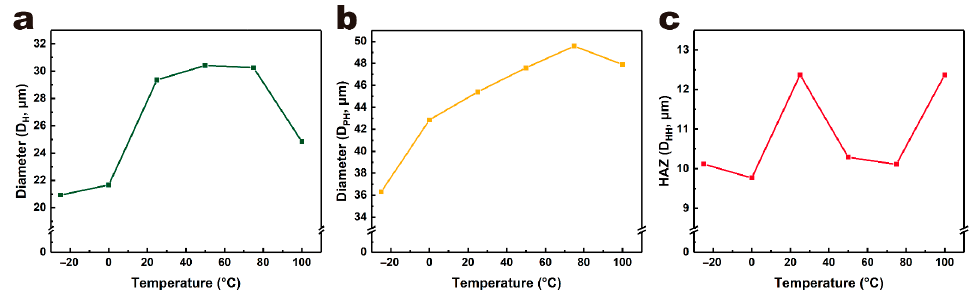
Figure 9. Hole diameter ( a ), processing area diameter ( b ) and HAZ ( c ) of PET films at different ambient temperature in the single spot laser processing experiment.